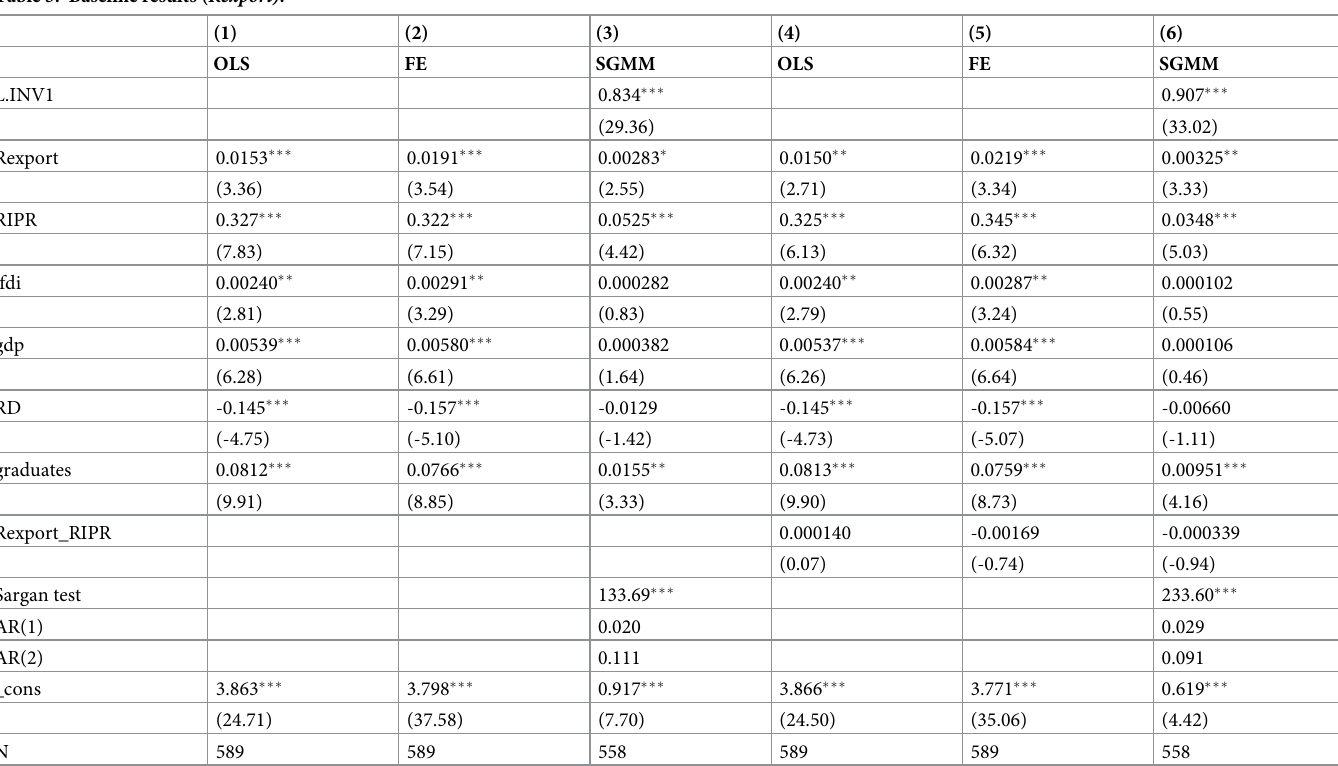
Table 5. Baseline results ( Rexport) .